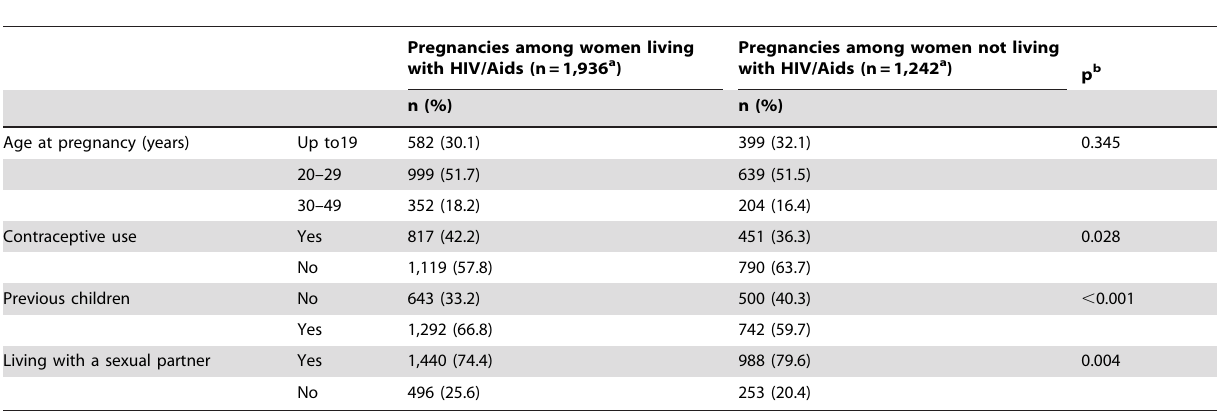
Table 2. Description of pregnancies occurred among women living with HIV/AIDS and women not living with HIV/AIDS according to characteristics linked to the specific context of each